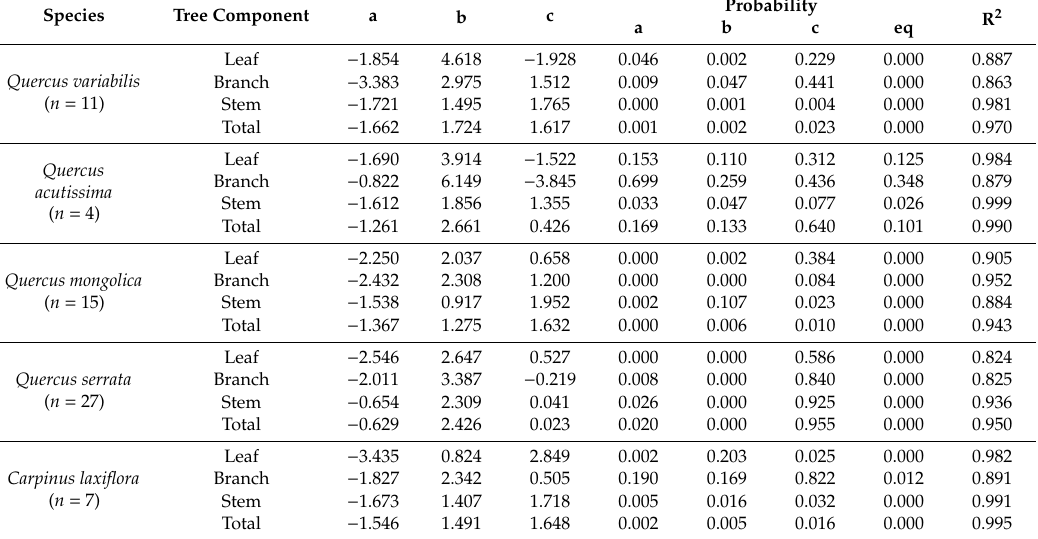
Table 4. Regressions coe ffi cients, their probabilities, and determination coe ffi cients of tree component dry mass (kg) on diameter (cm) at breast height (DBH), height (m) and equation (eq) for 5 species of understory vegetation in the Pinus rigida plantation. Equations follow the form: log Y = a + b log D + c log H, where D is stem DBH, H is tree height and Y is component dry mass. “ n ” means the number of trees of each species that were destructively sampled in this